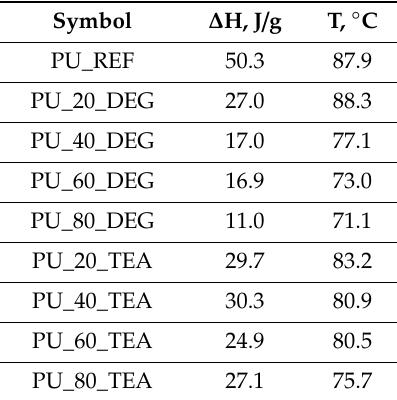
Figure 10. DSC thermograms of materials. Table 6. Results of DSC